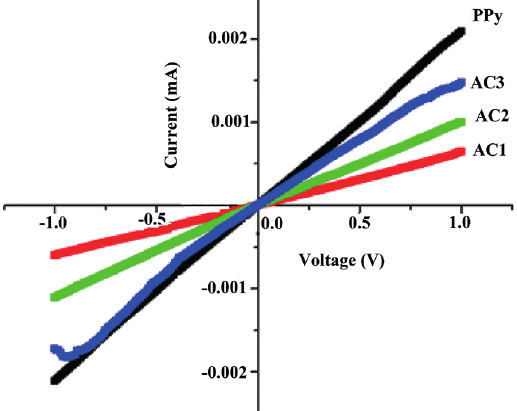
Figure 8. Current-voltage (I-V) characteristics of PPy and PPy/ (Ag S-CdS) hybrid 2